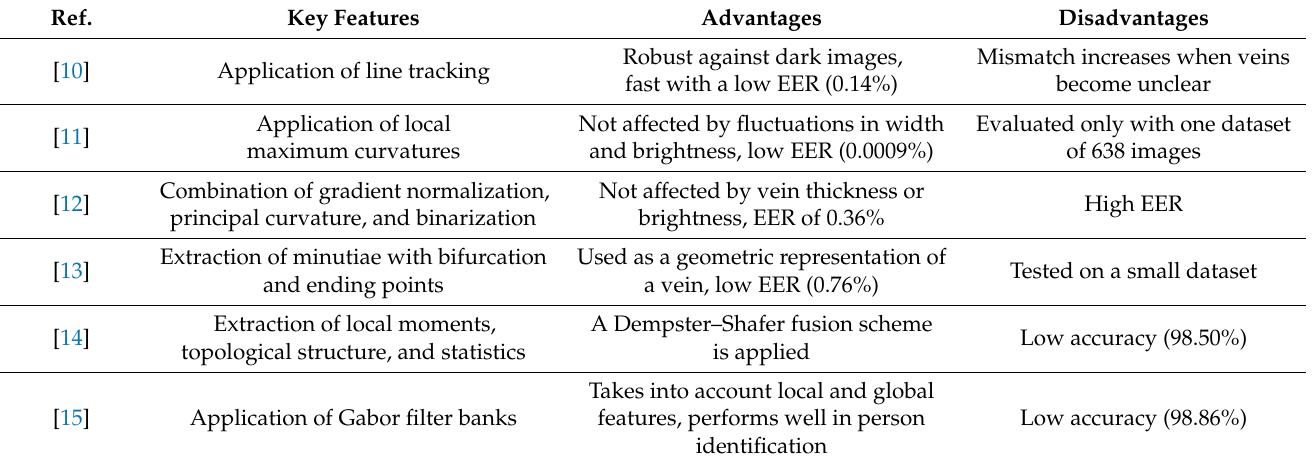
Table 1. Characteristics of the vein-pattern-based feature extraction methodologies.